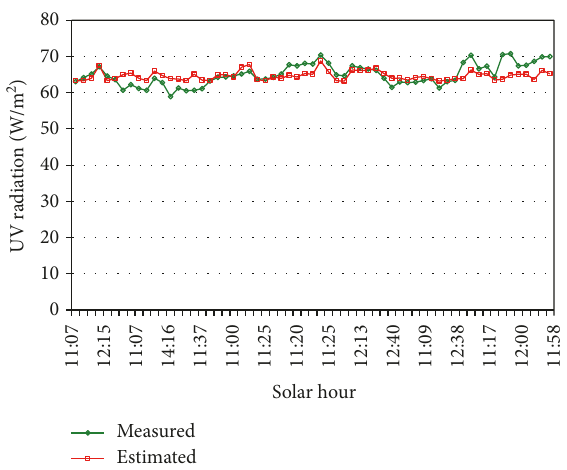
Figure 8: Comparison between the values estimated by the model and the experimental